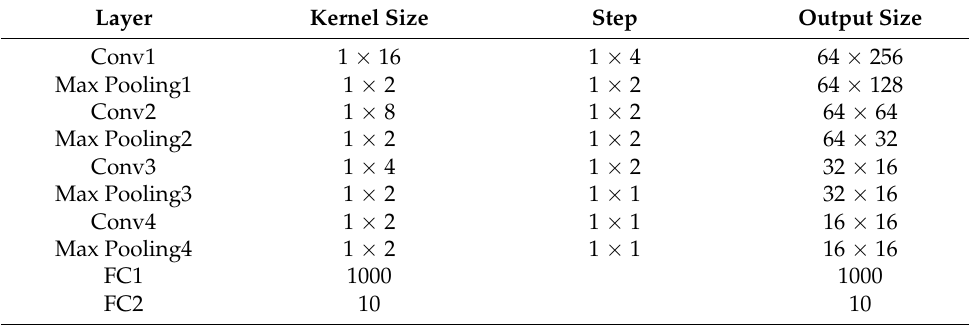
Table 2. 1DCNN model parameters.